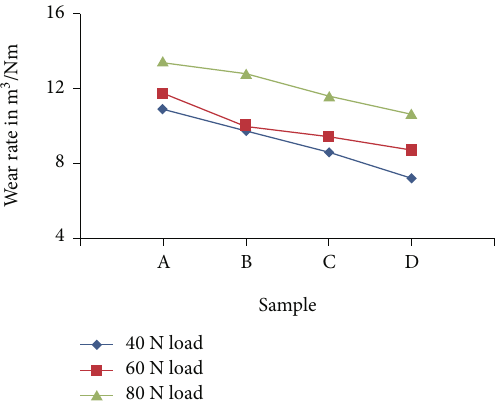
Figure 8: Dry-state wear rate of AA6061/Si nanocomposite (sample A- AA6061/0 wt% Si N , AA6061/8 wt% Si 4wt% Si 3 4